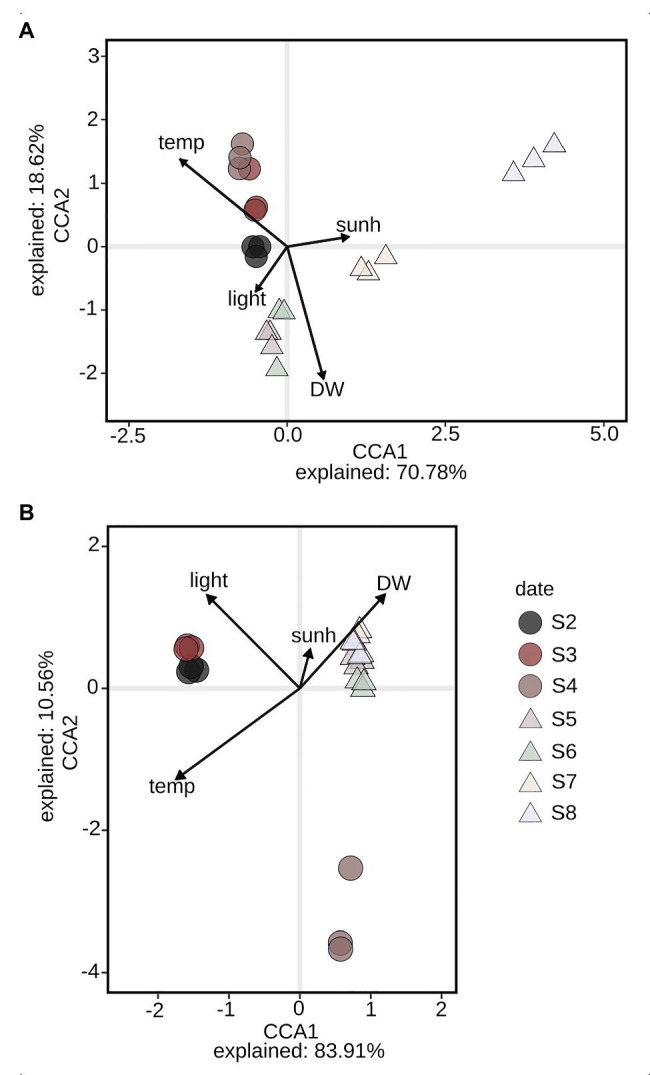
Canonical correspondence analysis (CCA) biplot of the eukaryote (A) and prokaryote (B) community, plotting samples with independent environmental parameters at each date of sampling (S2–S8) in the reactor: Temp – temperature in PBR (°C), DW – biomass dry weight (gl−1), sunh – number of sunshine hours at day of sampling (h), light – unshaded/shaded (reduced light input by 40–60%). Dates are denoted by color, warm period by (○), and cold period by (△). Date S1 is excluded due to missing nutrient data.